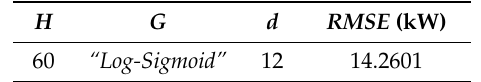
Table 2. The modelling parameters of the optimum ANN